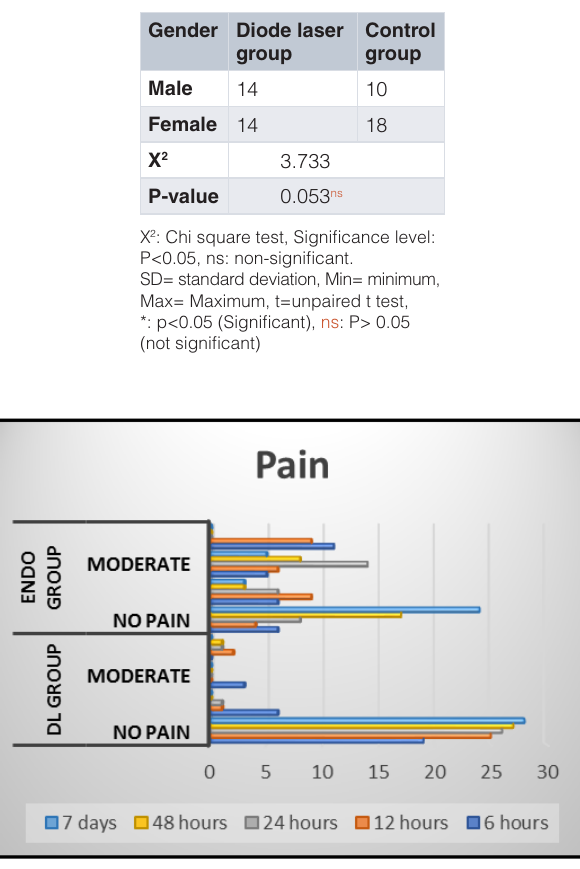
Figure 2. Column chart showing qualitative score of pain in patients enrolled in both groups. Means with different small letters in the same column indicate statistically significance difference, means with different capital letters in the same row indicate statistically significance difference. *; significant (p<0.05), ns; non- significant